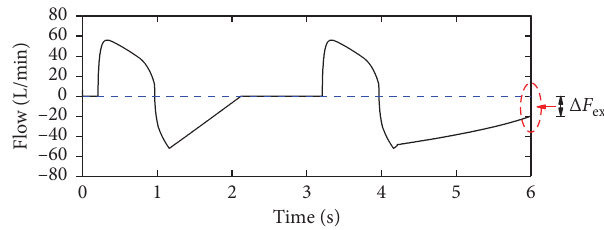
Figure 16: The effect of PEEPi on expiratory flow.